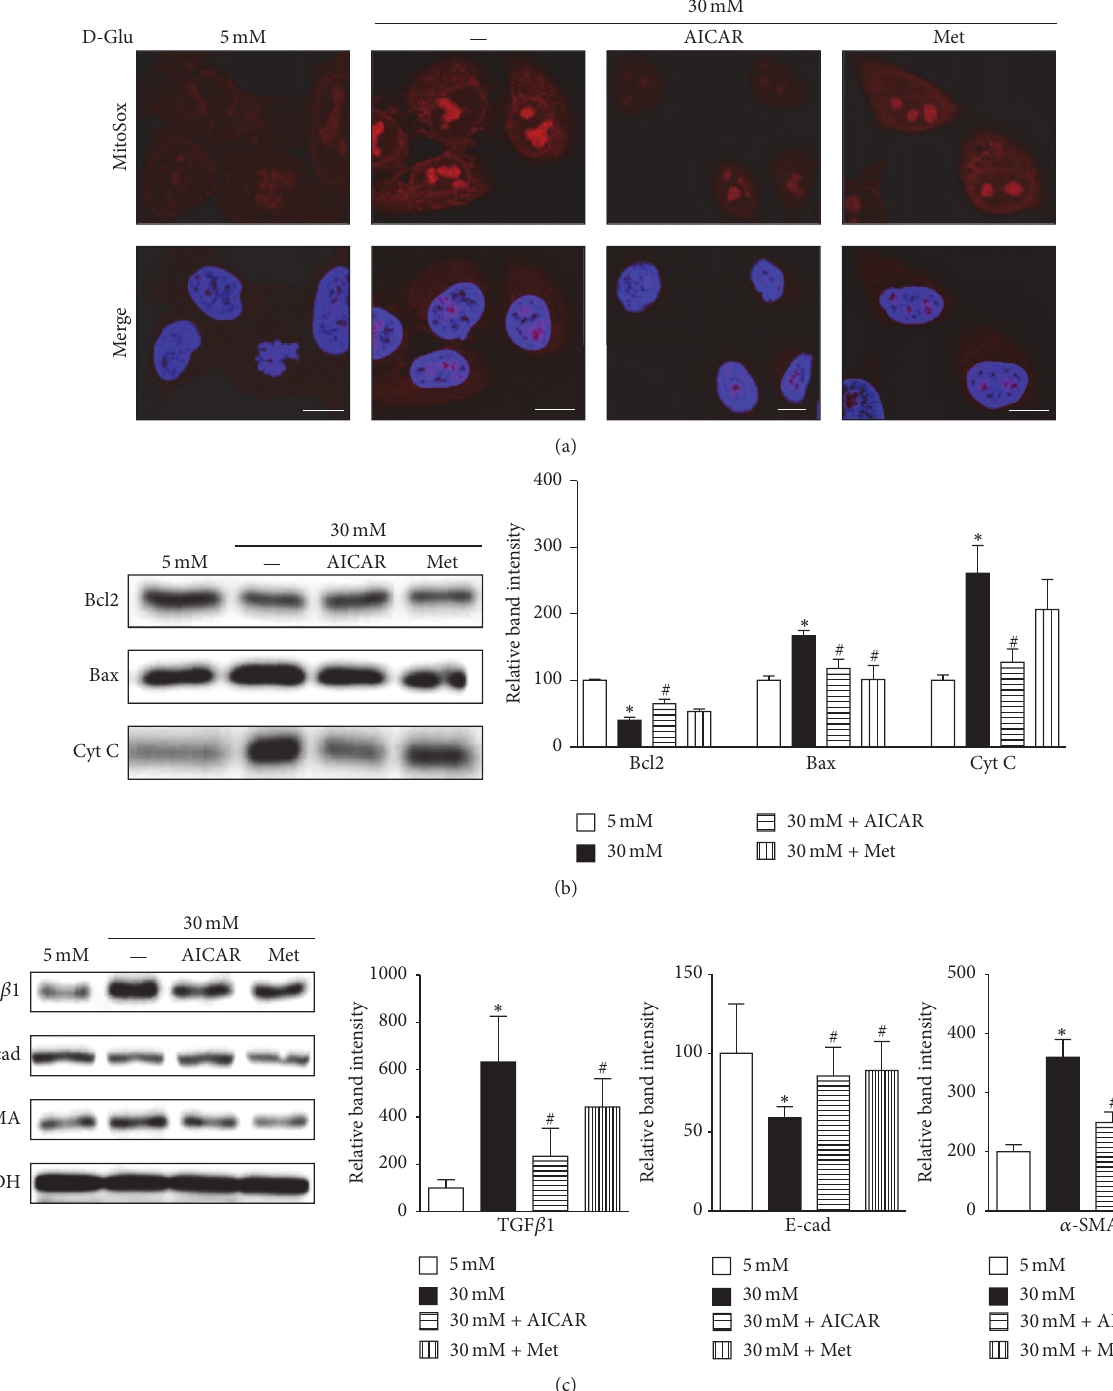
Figure 5: AICAR and metformin reduce ROS production and apoptosis and decrease TGF 𝛽 1 and 𝛼 SMA expression in human renal proximal tubular cells (RPTCs) exposed to high glucose (HG). (a) Representative confocal images of MitoSOX indicate a reduction in mitochondrial ROS production after treatment with AICAR or metformin in human RPTCs subjected to HG. (b) Western blot analyses reveal decreased expression of the apoptogenic proteins cytochrome C and Bax and increased expression of the antiapoptotic protein Bcl2 after AICAR or metformin treatment under HG conditions. (c) Western blot analyses show that AICAR or metformin treatment induces the downregulation of TGF 𝛽 1 and 𝛼 SMA, but upregulation of E-cad under HG conditions in human RPTCs ( ∗ 𝑝 < 0.05 versus 5 mM glucose; # 𝑝 < 0.05 versus 30 mM; scale bar 10 𝜇